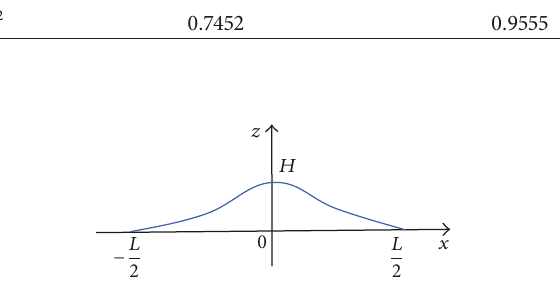
Figure 5: Parabolic cross-sectional profile curve of road bump.